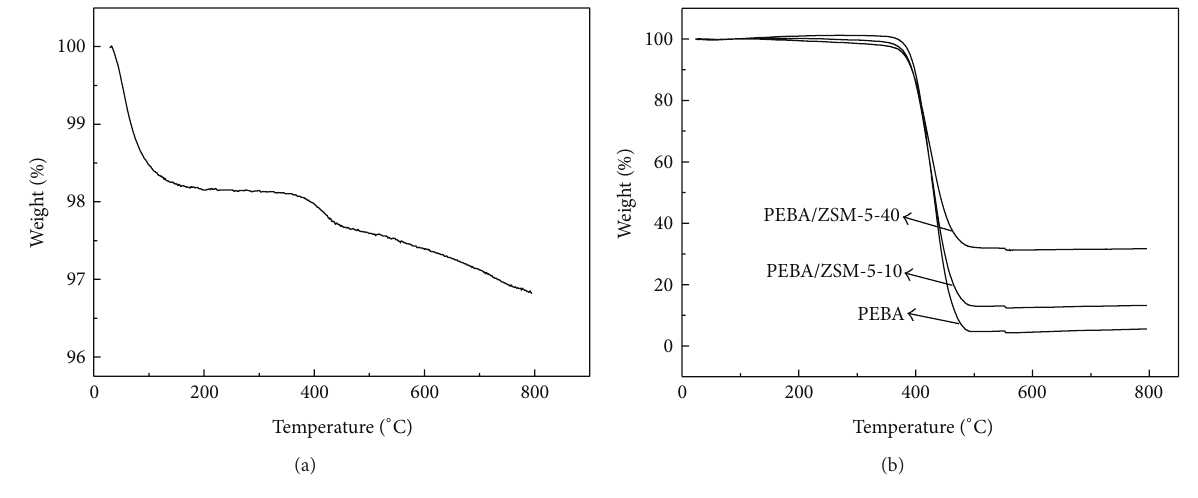
Figure 2: TGA plots of (a) ZSM-5 and (b)